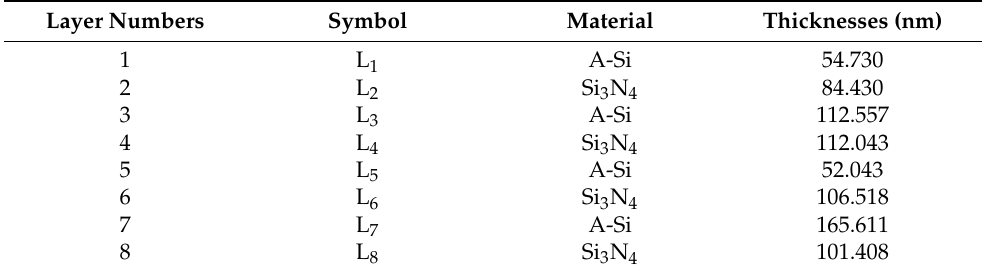
Figure 8. Ellipsometric fit to the proposed design extracted at 55 ◦ , 65 ◦ , and 75 ◦ . The obtained thicknesses of the cascaded filter via SE are provided in Table 2. Table 2. Thicknesses of deposited films extracted with the help of ellipsometry.